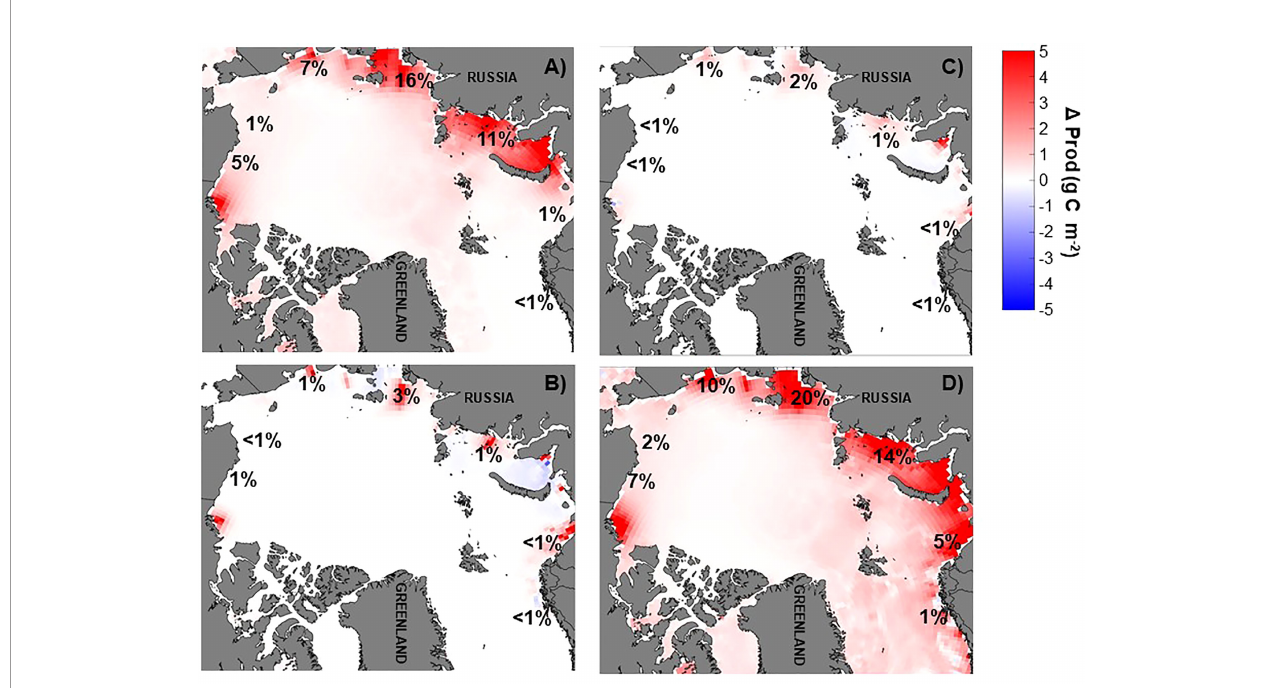
FIGURE 6 | Annual average primary production anomaly (g C m -2 ) relative to the baseline run [(NO3] EXP – (NO3) BASE ] for (A) doubling of river nitrate (N X2 ), (B) annual river nitrate climatology (N CLIM ), (C) river nitrate climatology shifted earlier by two months (N CLIMS2 ), and (D) river nitrate climatology doubled and shifted earlier by one month (N CLIMX2S1 ). Red colors indicate increased production over the baseline run while blue colors indicate lower production than the baseline run. Percentage change by coastal region is also indicated. All model results presented are ten years averages. Production was integrated over the upper 100 m in the upper mixed